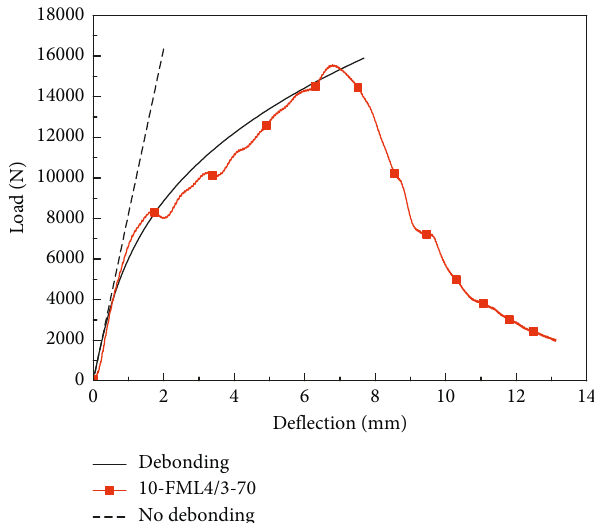
Figure 7: Load-deflection relation of the thick BFML plate con- trolled by bending force.